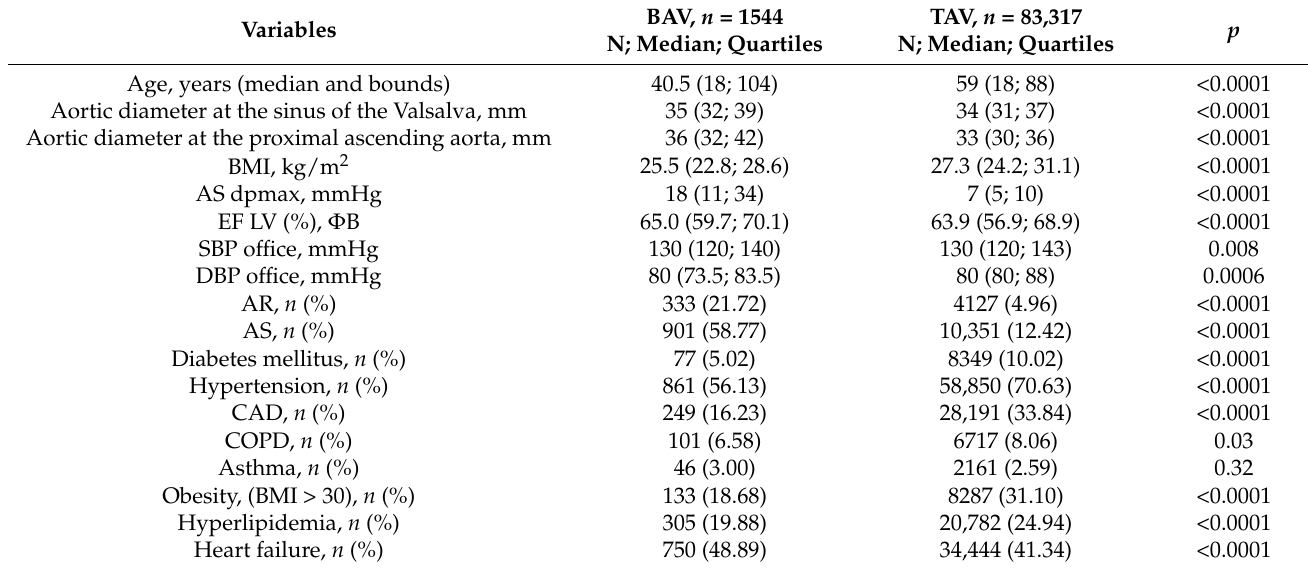
Table 2. Demographic and clinical characteristics of all patients depend on valve